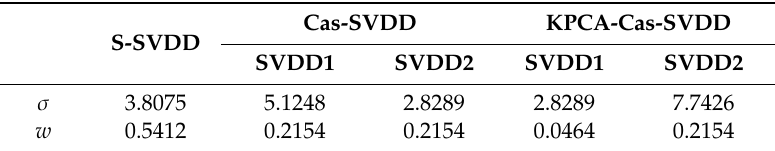
Table 4. Optimal parameters of SVDD.